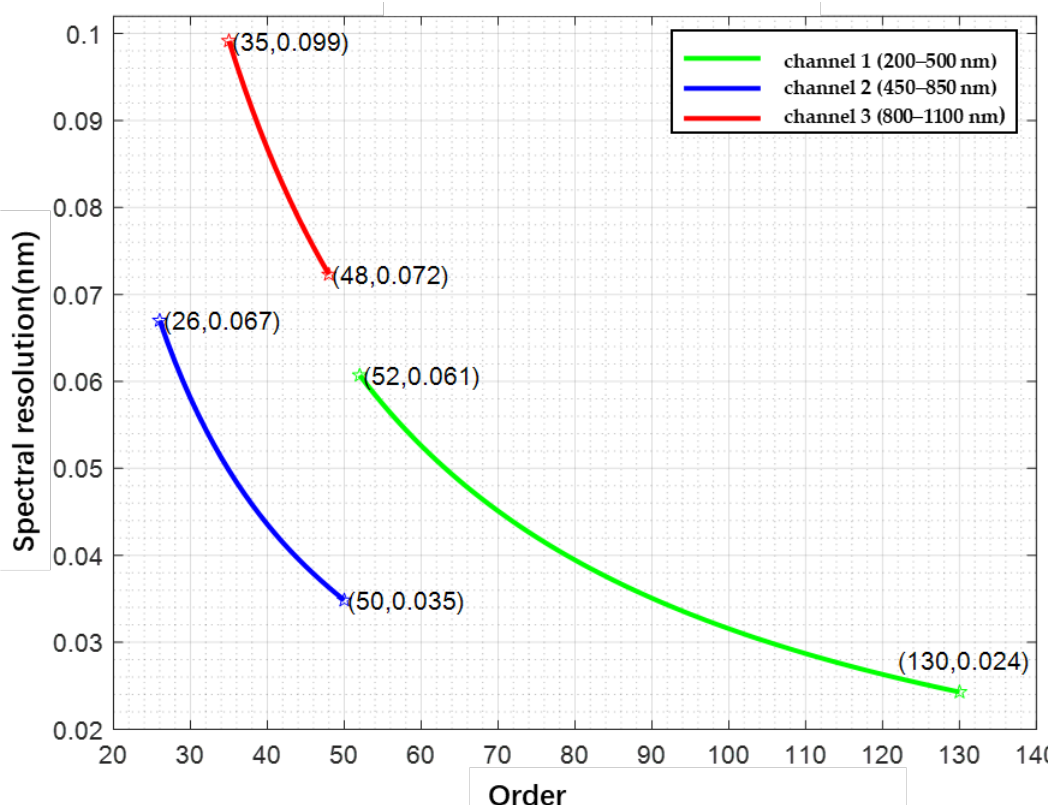
Figure 7. Spectral resolution — order curve of three channels.